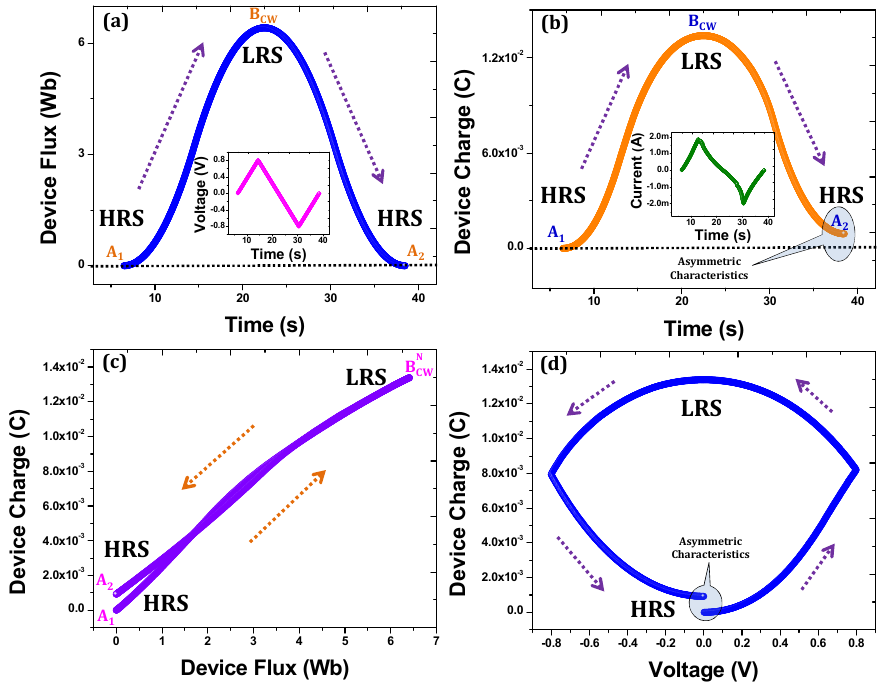
Figure 5. ( a ) Time domain flux and ( b ) time domain charge characteristics of the Ag/ZnO/FTO thin film memristive device. Insets shown in ( a ) and ( b ) represent the applied voltage signal and the corresponding output current signal, respectively. ( c ) Nonlinear and double-valued charge magnetic flux and ( d ) charge–voltage characteristics of the Ag/ZnO/FTO thin film memristive device. The CW represents the clockwise feature of the input signal. The transition of the device from the high-resistance state (HRS) to the low-resistance state (LRS) and vice versa are represented by dotted arrows.